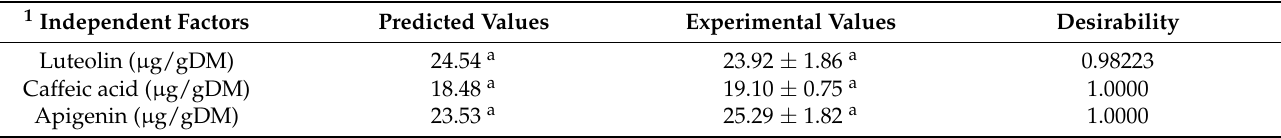
Table 5. Solution for maximum extraction of luteolin, caffeic acid, and apigenin from dried parsley sample. Predicted